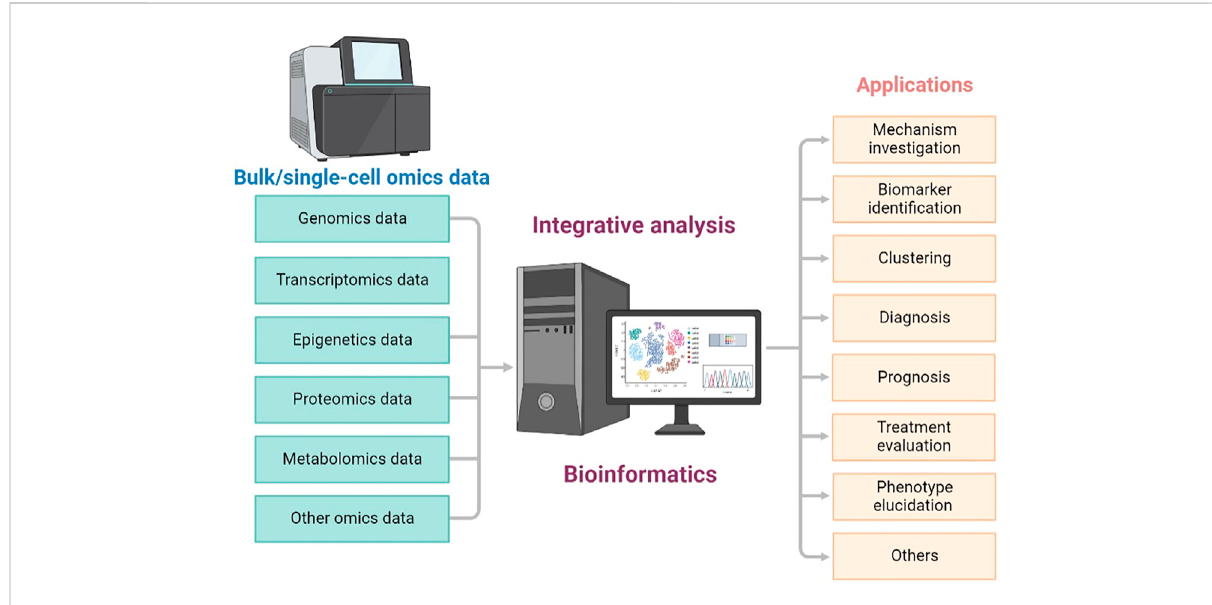
FIGURE 1 Overview of integrative analysis of multi-omics data generated from different bulk and single-cell sequencing technologies.